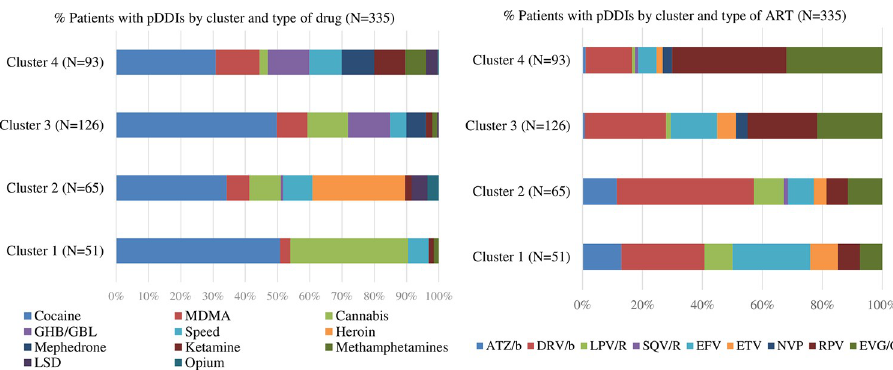
Fig 5. Prevalence of potential interactions per cluster and type of drug and antiretroviral therapy. MDMA: 3,4-Methylenedioxymethamfetamine; GHB/GBL: gamma-Hydroxybutyrate/gamma-Butyrolactone; LSD: Lysergic acid diethylamide; DRV/b: Darunavir boosted; RPV: Rilpivirine; EVG/C: Elvitegravir/cobicistat; EFV: Efavirenz; ETV: Etravirine; ATZ/b: Atazanavir boosted; LPV/R: Lopinavir/ritonavir; NVP: Nevirapine; SQV/R: Saquinavir/ritonavir; ART: Antiretroviral; pDDIs: Potential drug-drug interactions; N: Patients.